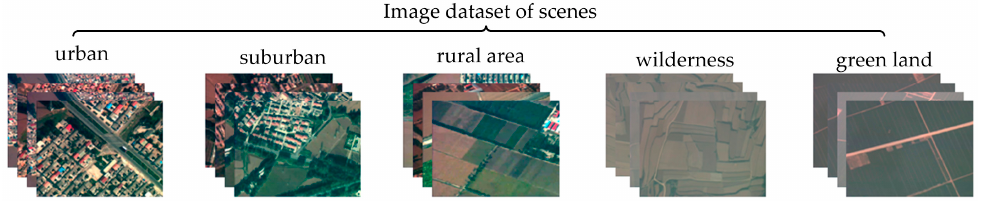
Figure 5. Scene recognition of aerial images. The method includes three steps: superpixel-based low- level feature extraction, Bag-of-Words model-based middle-level semantic feature extraction, and SVM-based classification.